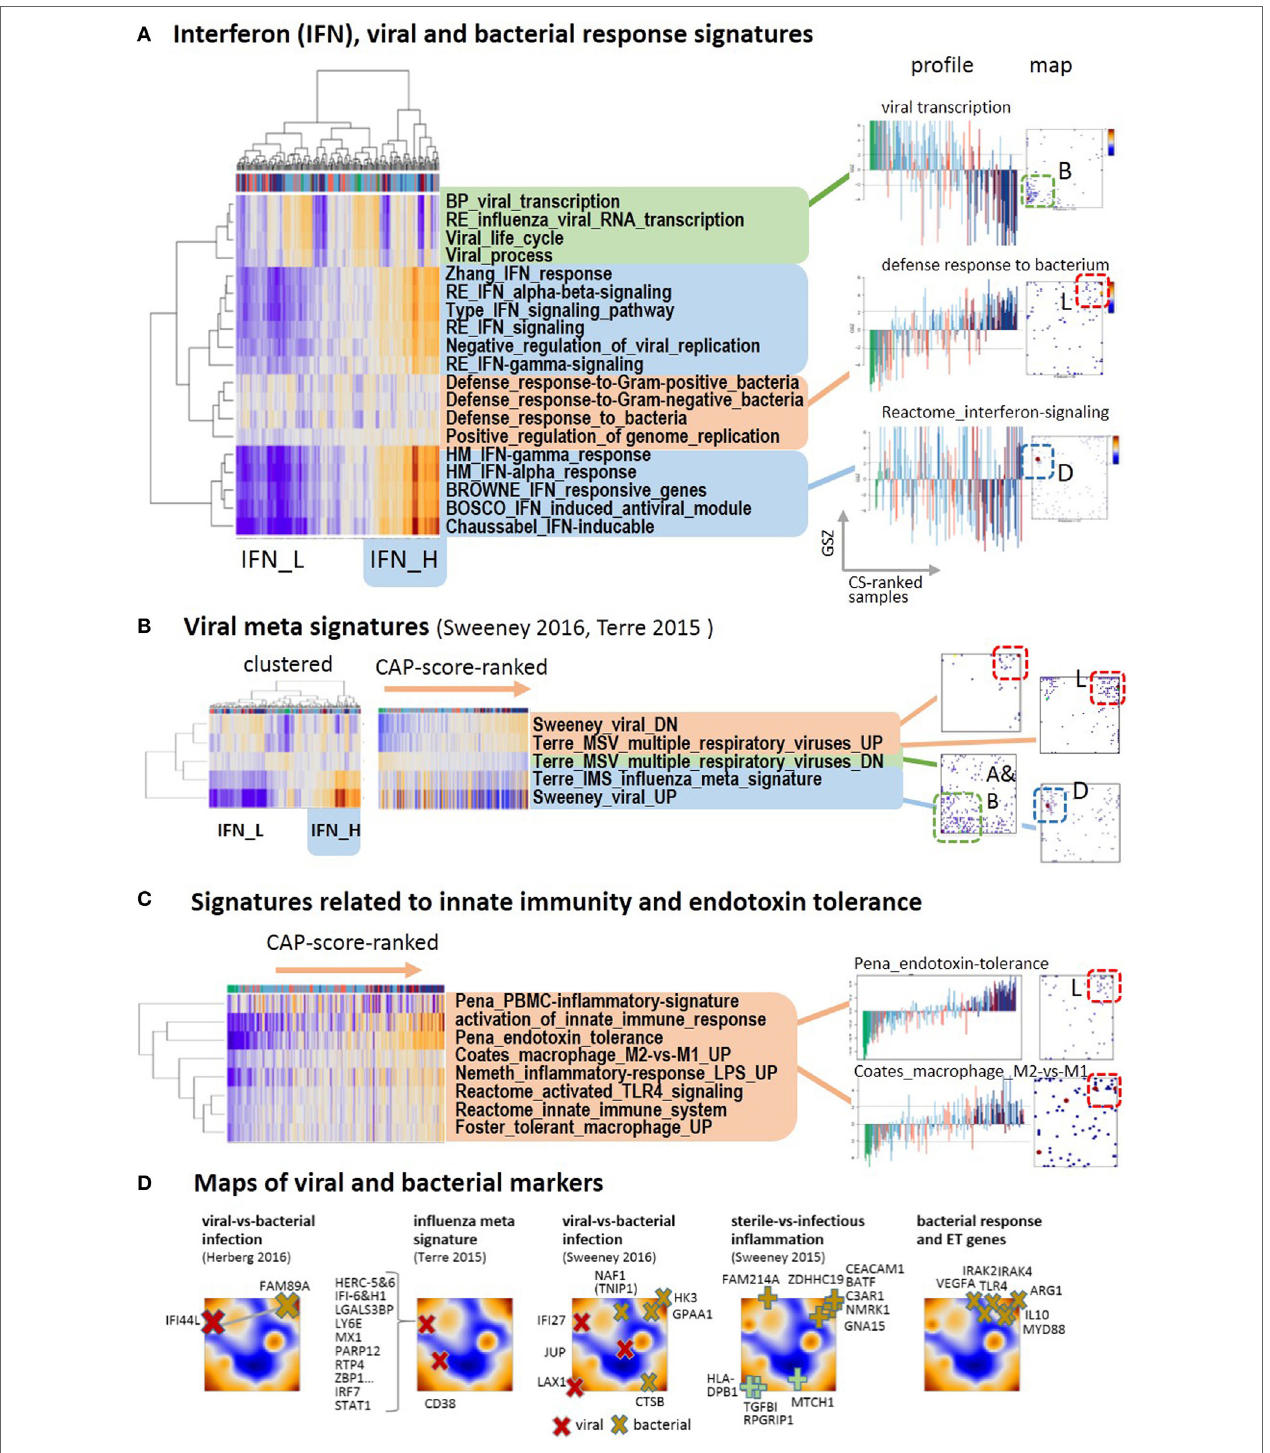
FigUre 4 | Footprints of infections in the community-acquired pneumonia (CAP) transcriptome: (a) two-way hierarchical clustering of interferon-related, bacterial and viral response signatures reveals two clusters of IFN-high (IFN-H) and IFN-low (IFN-L) responsive cases, in addition to clusters of cases with up and down regulated expression according to CAP severity. The IFN-responsive genes accumulate strongly in spot D. (B) Gene sets from recent meta-analyses (46, 47) split into the same clusters as the gene sets in part A. The IFN-responsiveness associates with the signature for viral infections. The respective genes accumulate in different characteristic spot areas of the map. (c) The expression of gene signatures related to bacterial infections and endotoxin tolerance taken from Ref. (48–51) increases with CAP severity. (D) Gene markers that differentiate between different types of infections taken from Ref. (46, 47, 52) are mapped into the expression self organizing map. They locate typically in/near spots D (viral markers), L (bacterial and ET markers), and A (sterile